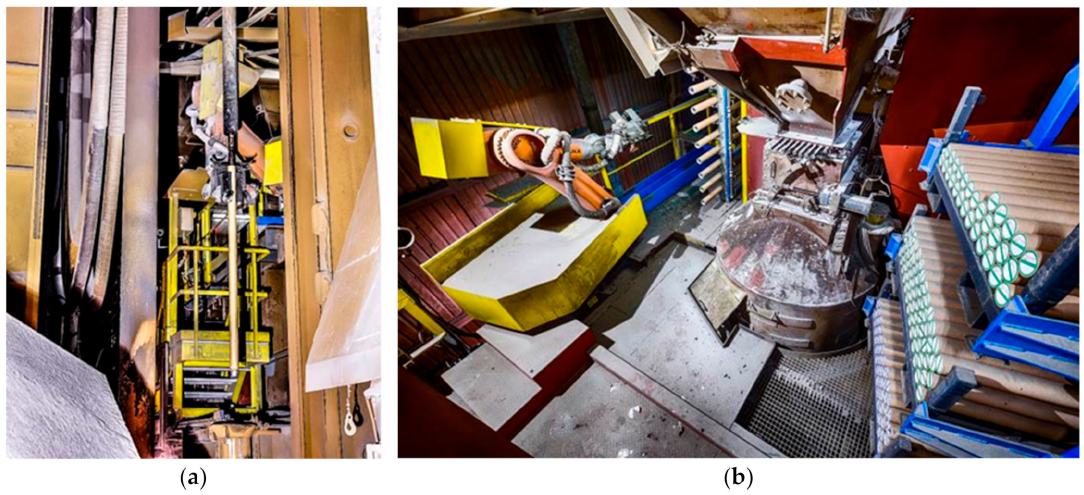
Figure 8. Installation of the new sublance probe manipulation system. The robot attaches the probe to the sublance ( a ); robot with the magazine for probe storage ( b ) [32].